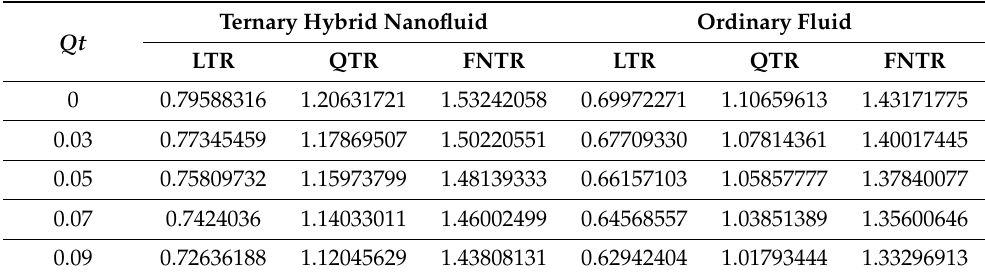
Table 5. Nur values versus Qt for the LTR, QTR, and FNTR cases.